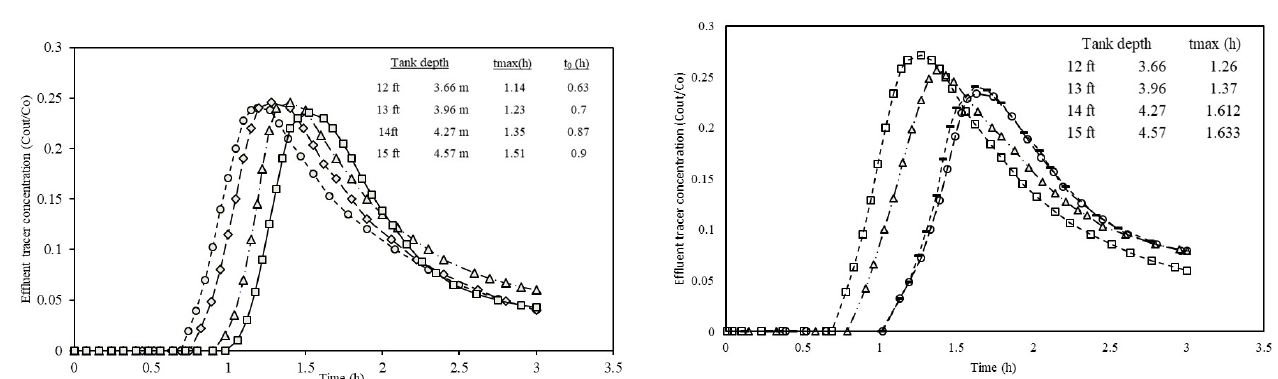
Figure 5. Effluent concentration with a baffle height of 1.52m in tank depth variations.